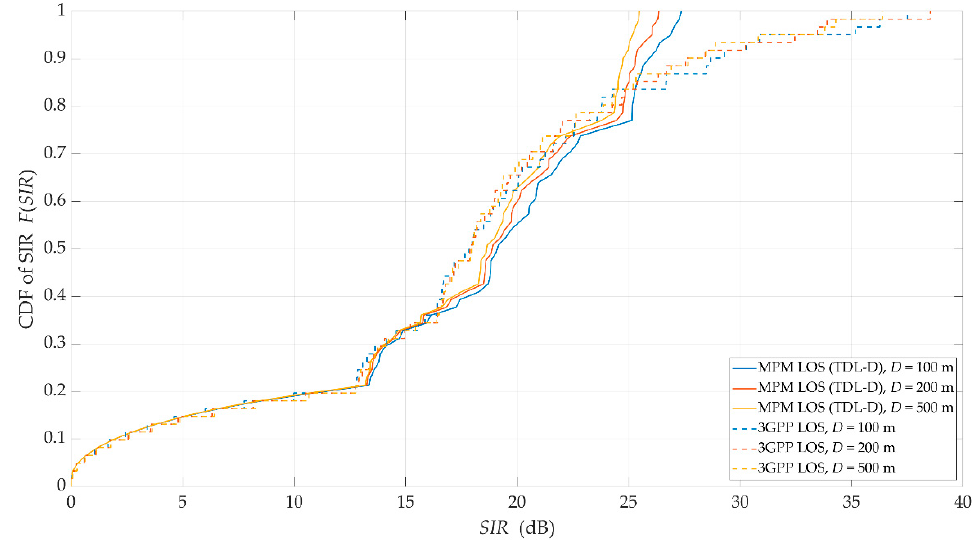
Figure 8. Cumulative distribution functions (CDFs) of SIR for LOS conditions and selected distances obtained for the MPM and 3GPP model.